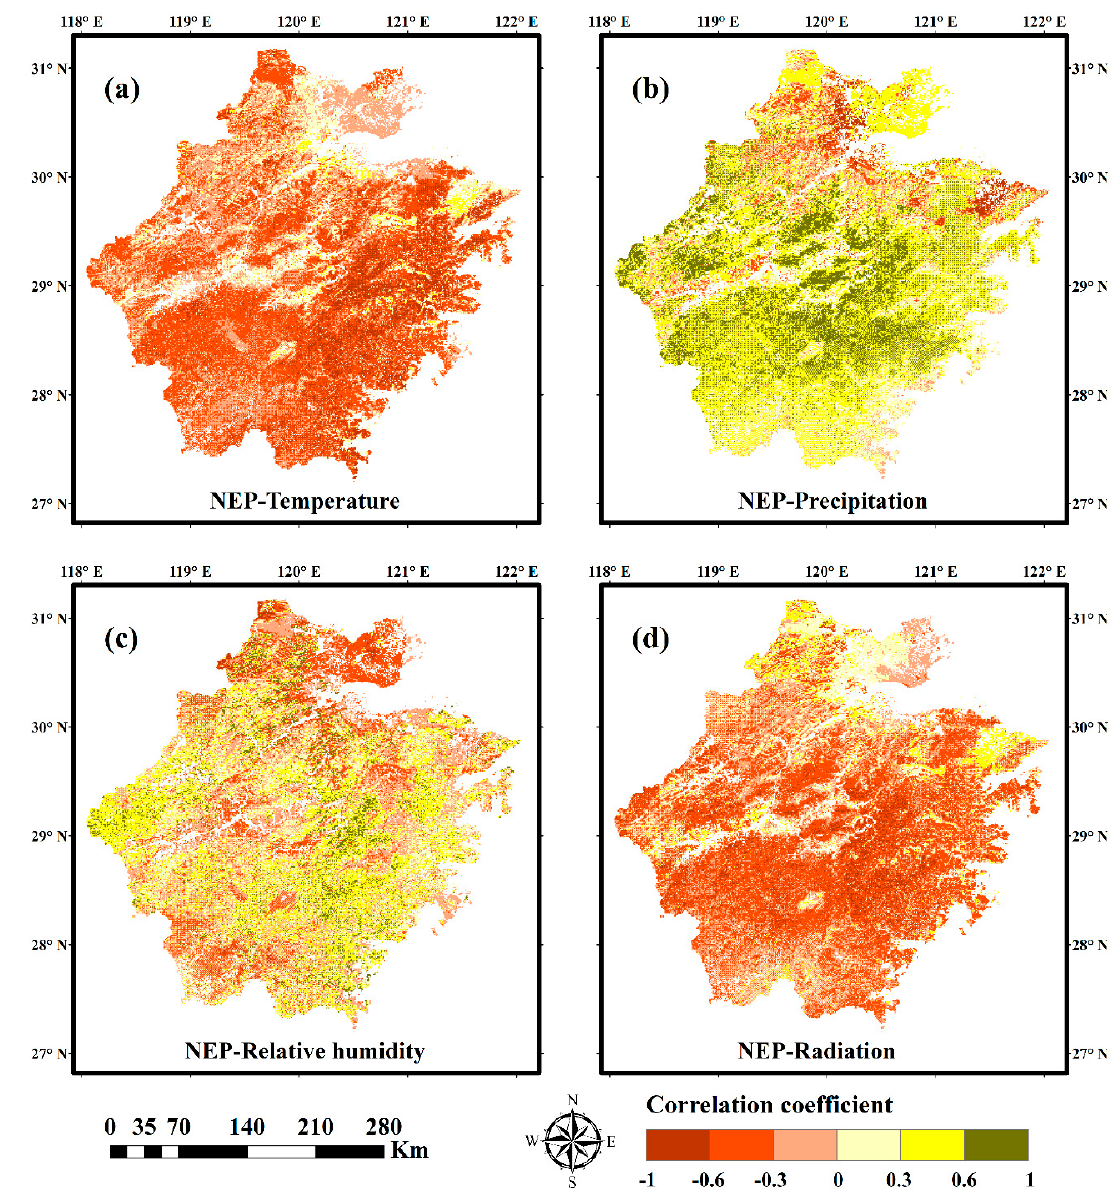
Figure 13. The spatial distribution of the correlation relationships between forest NEP and ( a ) temperature, ( b ) precipitation, ( c ) relative humidity, and ( d ) radiation in Zhejiang Province from 2000 to 2015.